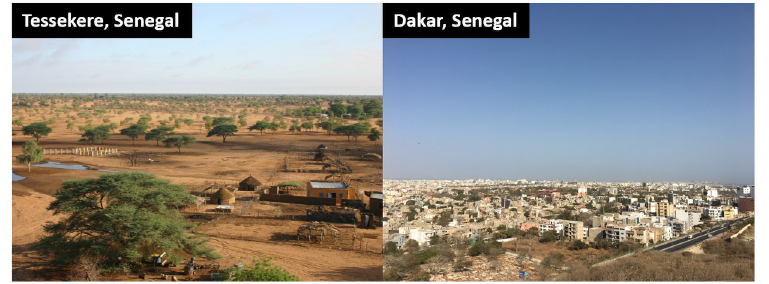
Fig 1. Photographs of the city of Dakar and part of the commune of Tessekere (Senegal) (G Boe¨tsch; E Macia).